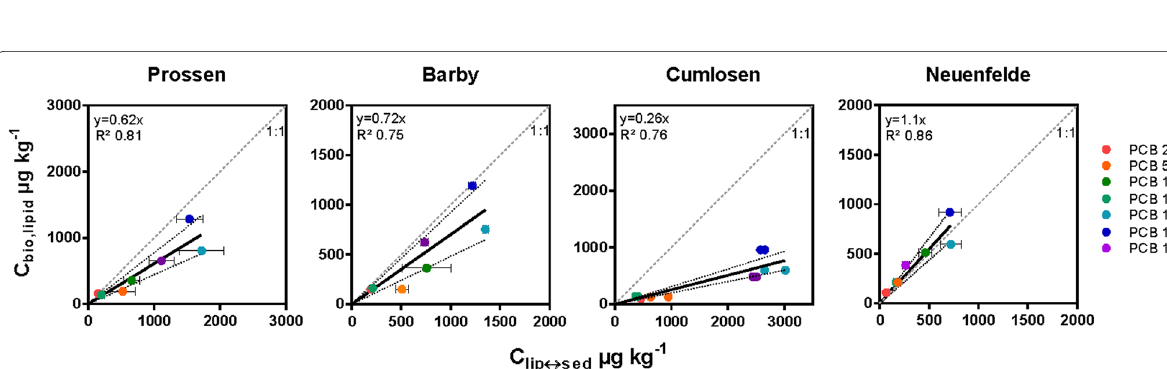
values are mean values ↔ sed